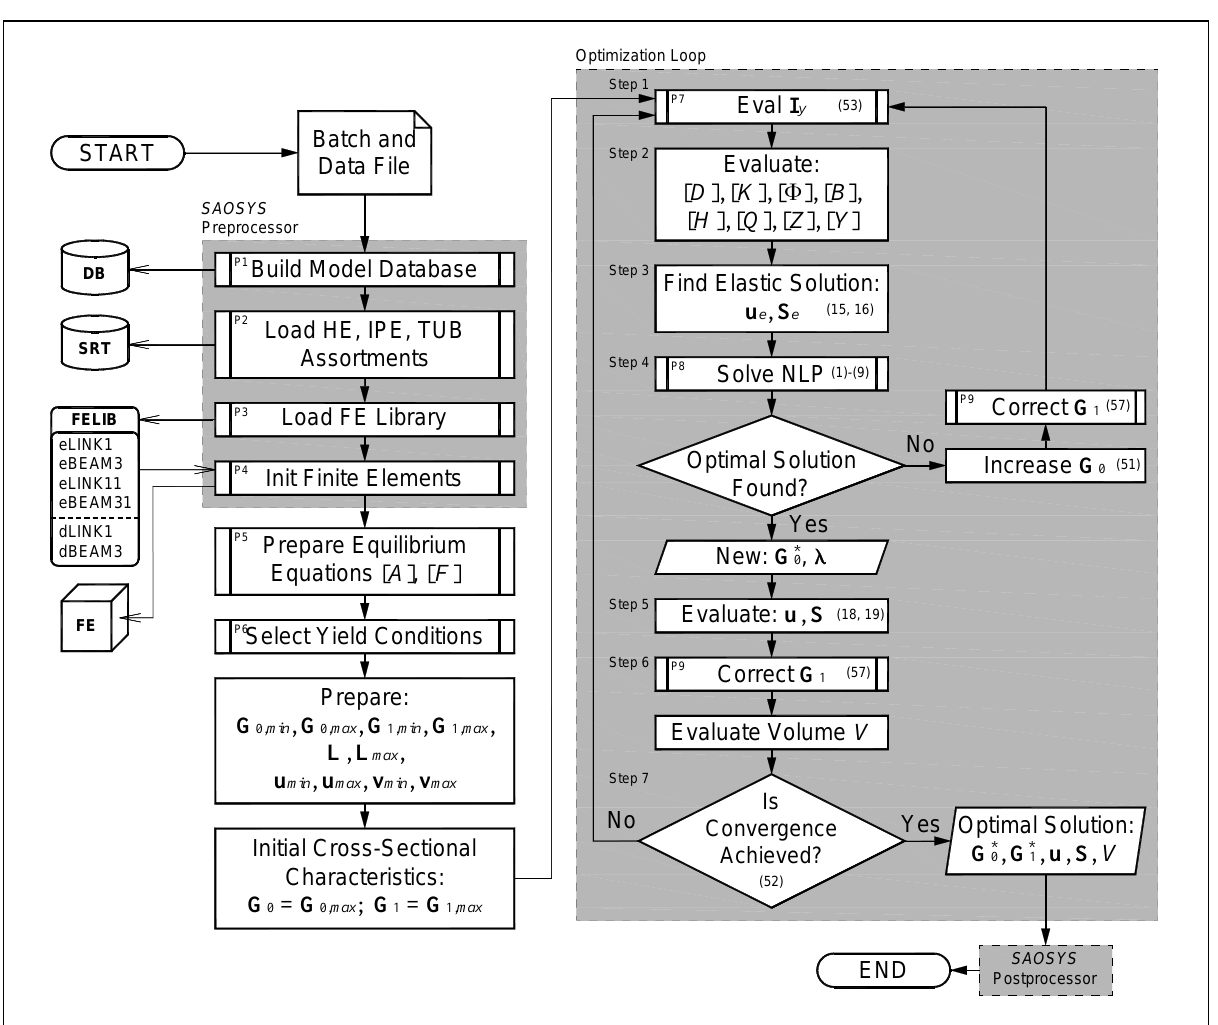
Fig. 9. Design algorithm SAOSYS-EPSOptim for elastic-plastic steel